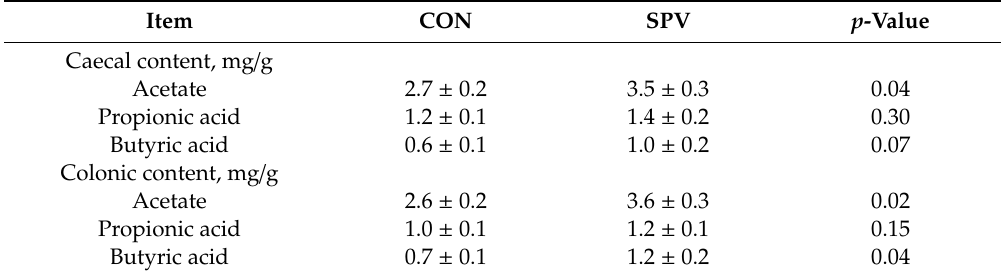
Table 4. E ff ect of sweet potato vine treatment on concentrations of acetate, propionic acid, and butyric acid in caecal and colonic digesta of Meishan gilts.